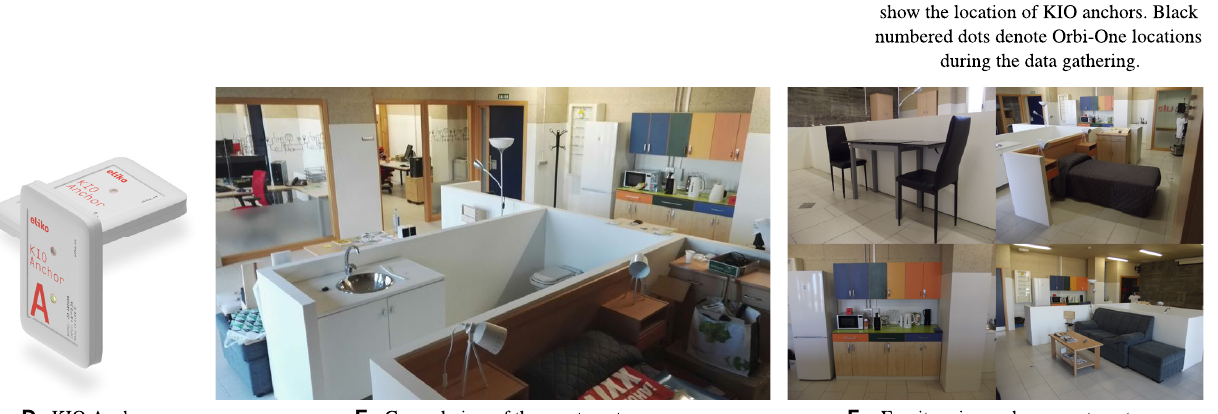
FIgURe 1 | Materials used in the experiments. (a) Orbi-One robot. (B) Leon@Home Testbed plan. (C) Floor plan of the apartment. Red dots show the location of KIO anchors. Black numbered dots denote Orbi-One locations during the data gathering. (D) KIO anchors. (e) General view of the apartment. (F) Furniture in mock-up apartment.